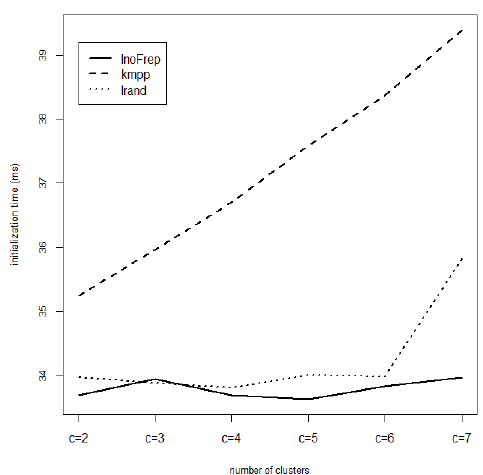
Figure 4. Initialization time (ms) by the compared initialization algorithms.